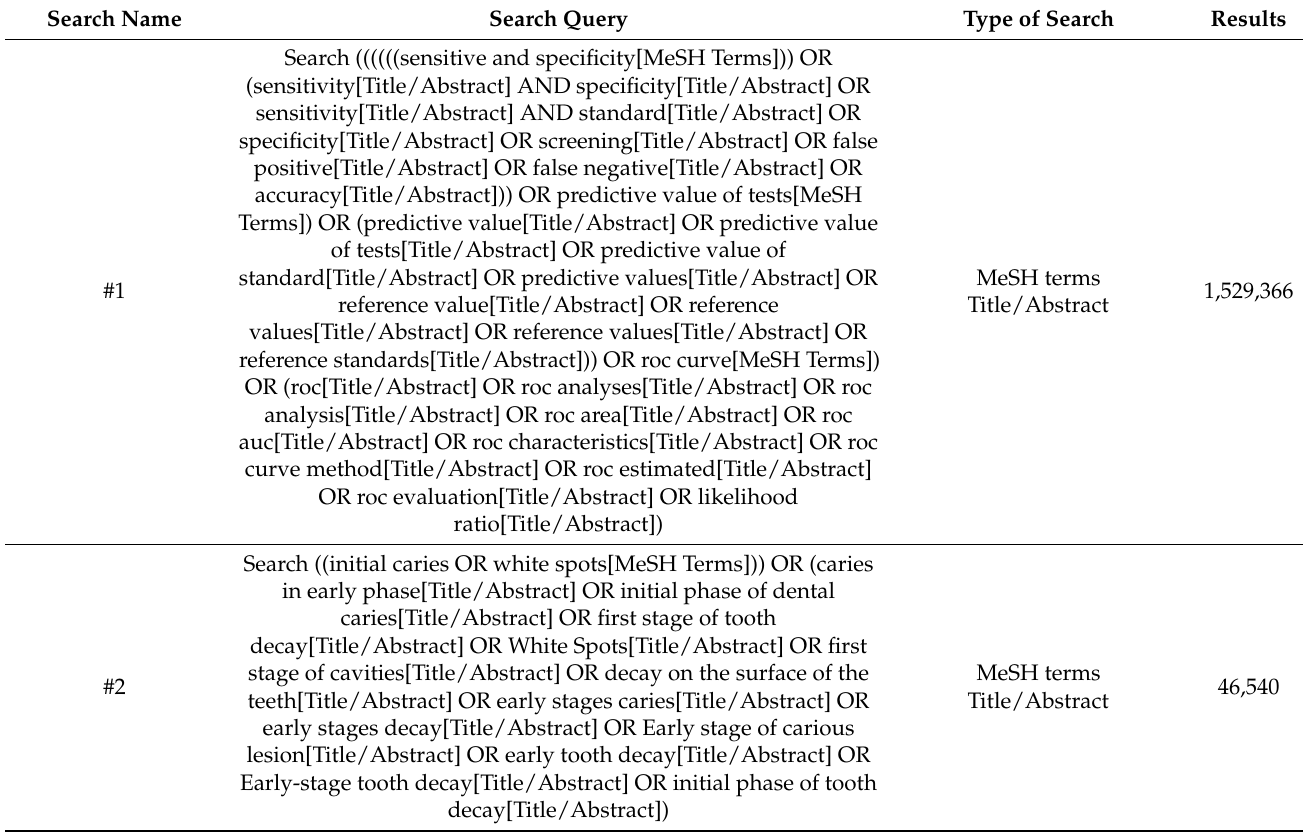
Table A1. PubMed search: diagnostic value of fluorescence methods, visual inspection and photographic visual examination in initial caries